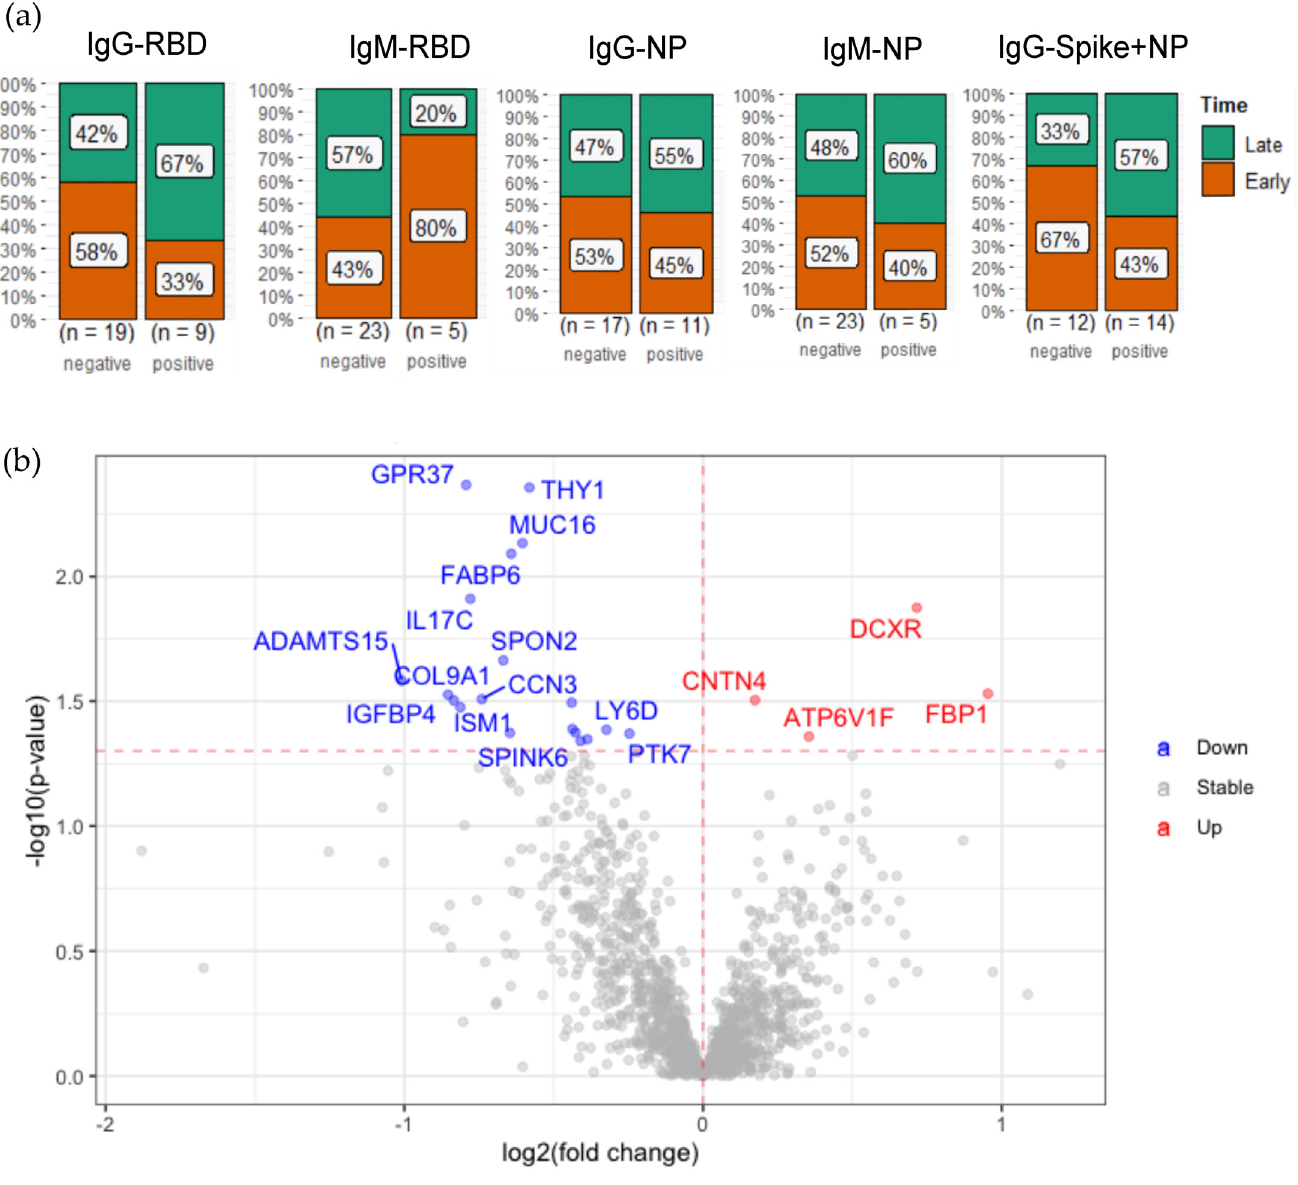
Figure 4. Plasma protein changes associated with SARS-CoV-2 antibody generation. ( a ) Bar plots represent the percentage of patients with positive and negative antibody generation for different SARS-CoV-2 antigens from patients with early-collected plasma (<3 months) and late-collected plasma (>3 months); ( b ) volcano plot of statistical significance against fold-change of proteins between patients with positive antibody generation and patients with negative antibody generation. The red (upregulated in patients with positive antibody generation) and blue (downregulated in patients with positive antibody generation) dots statistically indicate DEPs.